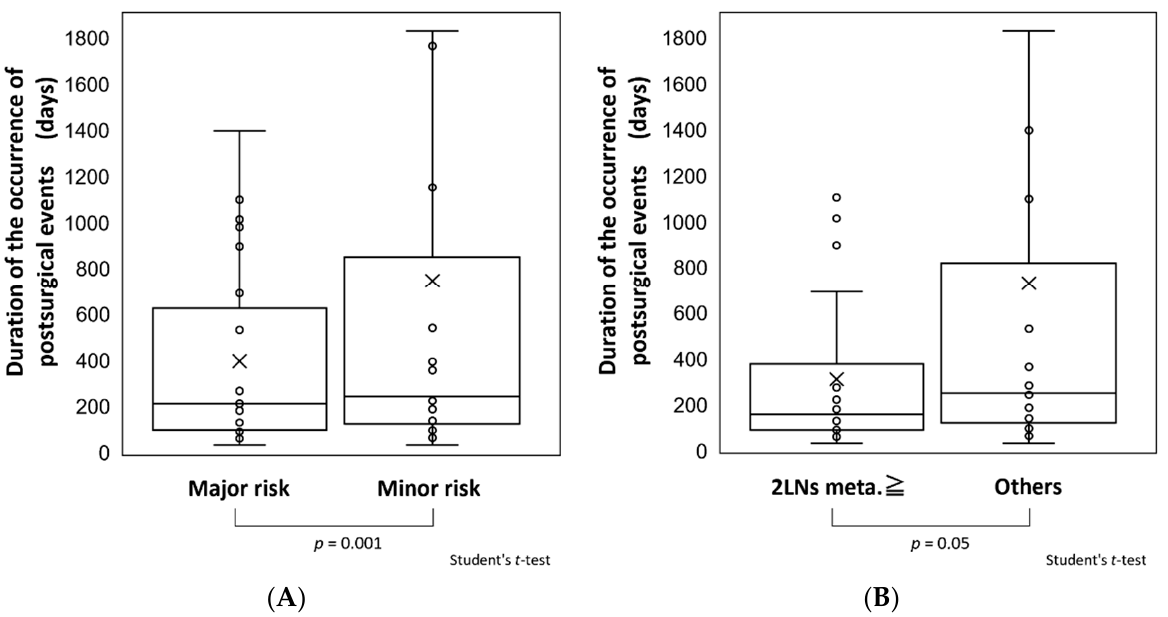
Figure 6. ( A ). Comparisons of periods until occurrence of postsurgical events in the major and minor risk groups. The mean times of occurrence of events were 396.4 days (Q 2/4 213 days, Q 3/4 625 days) and 747 days (Q 2/4 224 days, Q 3/4 851.5) in the major and minor risk groups, respectively, with significantly earlier occurrence in the major risk group ( p = 0.001). ( B ). Comparisons of periods until occurrence of postsurgical events in patients with metastasis to <2 or ≥ 2 cervical lymph nodes (LNs). The mean times of occurrence of events were 312.2 days (Q 2/4 160 days, Q 3/4 379.3 days) and 730.9 days (Q 2/4 252 days, Q 3/4 820 days) in patients with metastasis to <2 or ≥ 2 LNs, respectively, with significantly earlier occurrence in patients with ≥ 2 metastases ( p = 0.05). In the figure, “ × ” indicates the mean value and “ ○ ” indicates the event occurrence per patient.